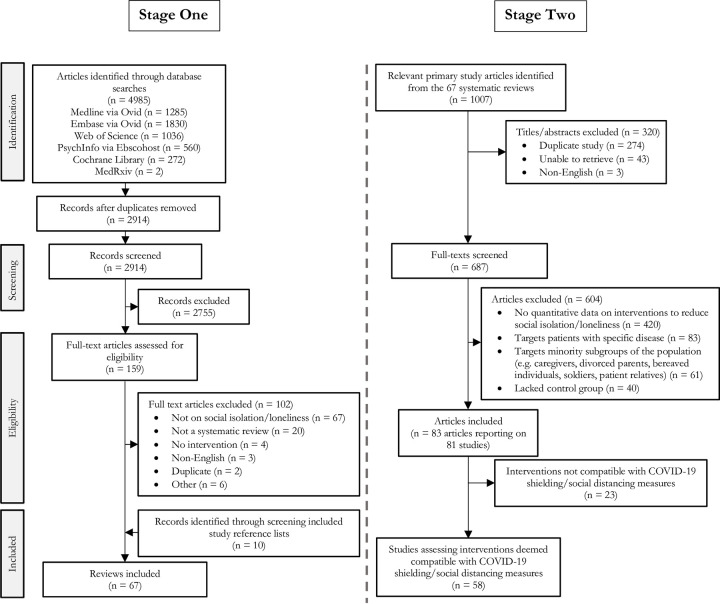
PRISMA flow diagram.